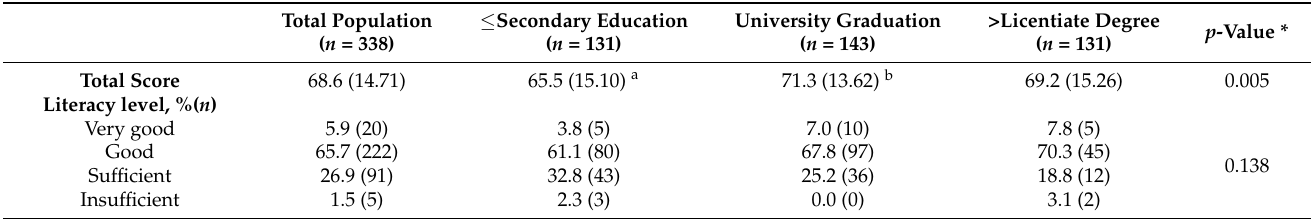
Table 7. The literacy level of the population studied according to educational qualifications. Total Population ( n = 338)